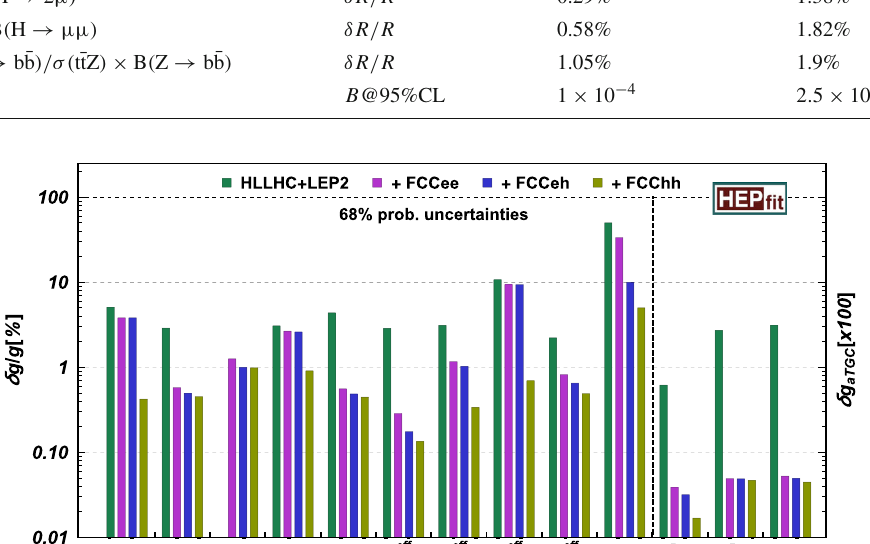
Fig. S.1 One- σ precision reach at the FCC on the effective single Higgs couplings, Higgs self-coupling, and anomalous triple gauge cou- plings in the EFT framework. Absolute precision in the EW measure- ments is assumed. The different bars illustrate the improvements that